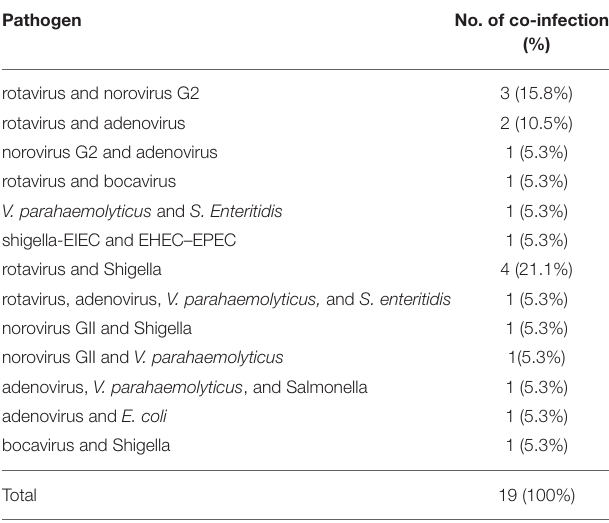
TABLE 3 | Cross-tabulation of the frequency of rotavirus infection among rotavirus-vaccinated and non-vaccinated subjects using A chi-square test.